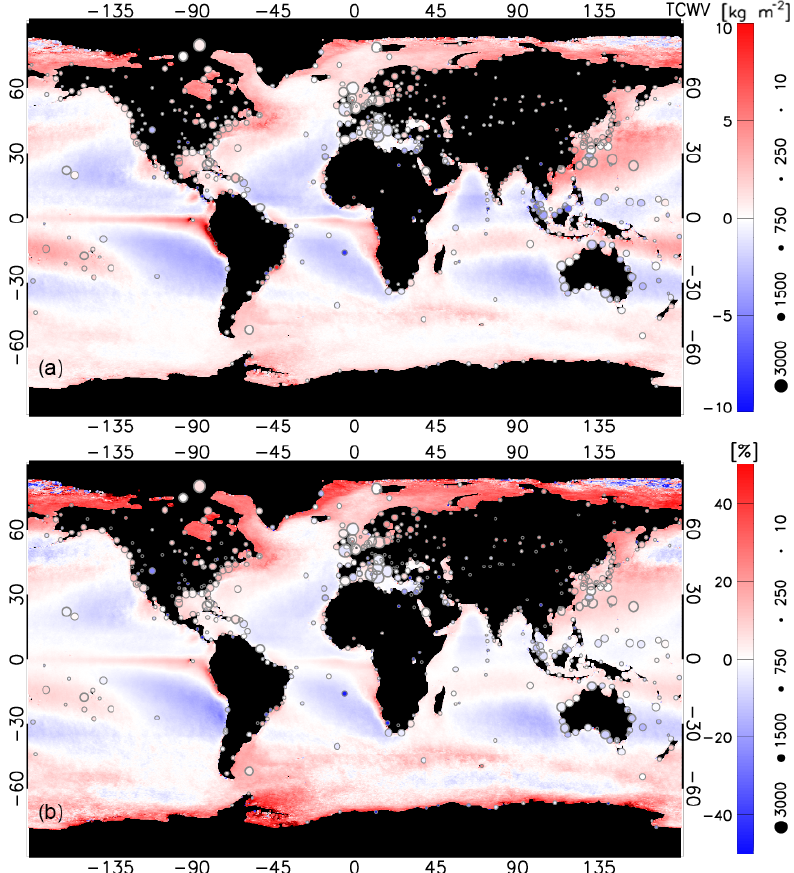
Figure 7. Average absolute (a) and relative (b) TCWV differences (SSM/I-AIRWAVE) at 0 . 25 ◦ × 0 . 25 ◦ spatial resolution. Average ARSA- AIRWAVE TCWV differences are overplotted with circles; the size of the symbols is proportional to the number of matches (see legend). The data cover the period from 1991 to